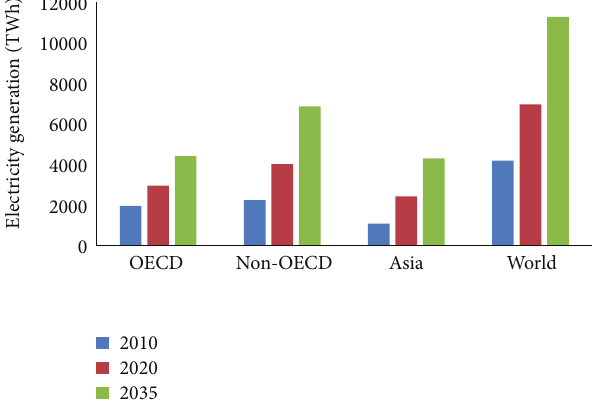
Figure 4: Renewable-based electricity generation by region